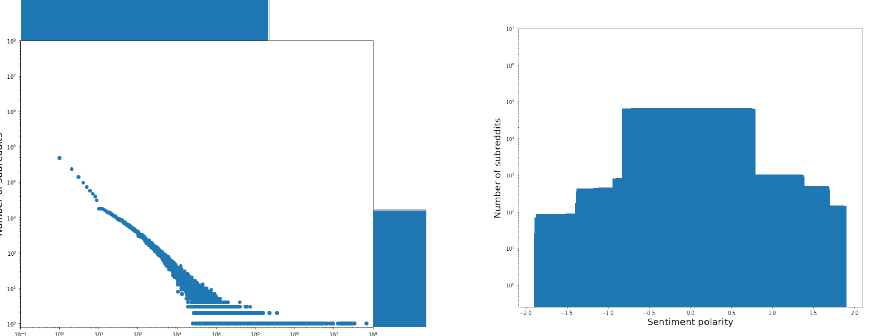
Figure 5. Distributions of subreddits against subscribers ( left , log–log scale, enriched with marginal distributions) and sentiment polarity of their description ( right , semi-logarithmic